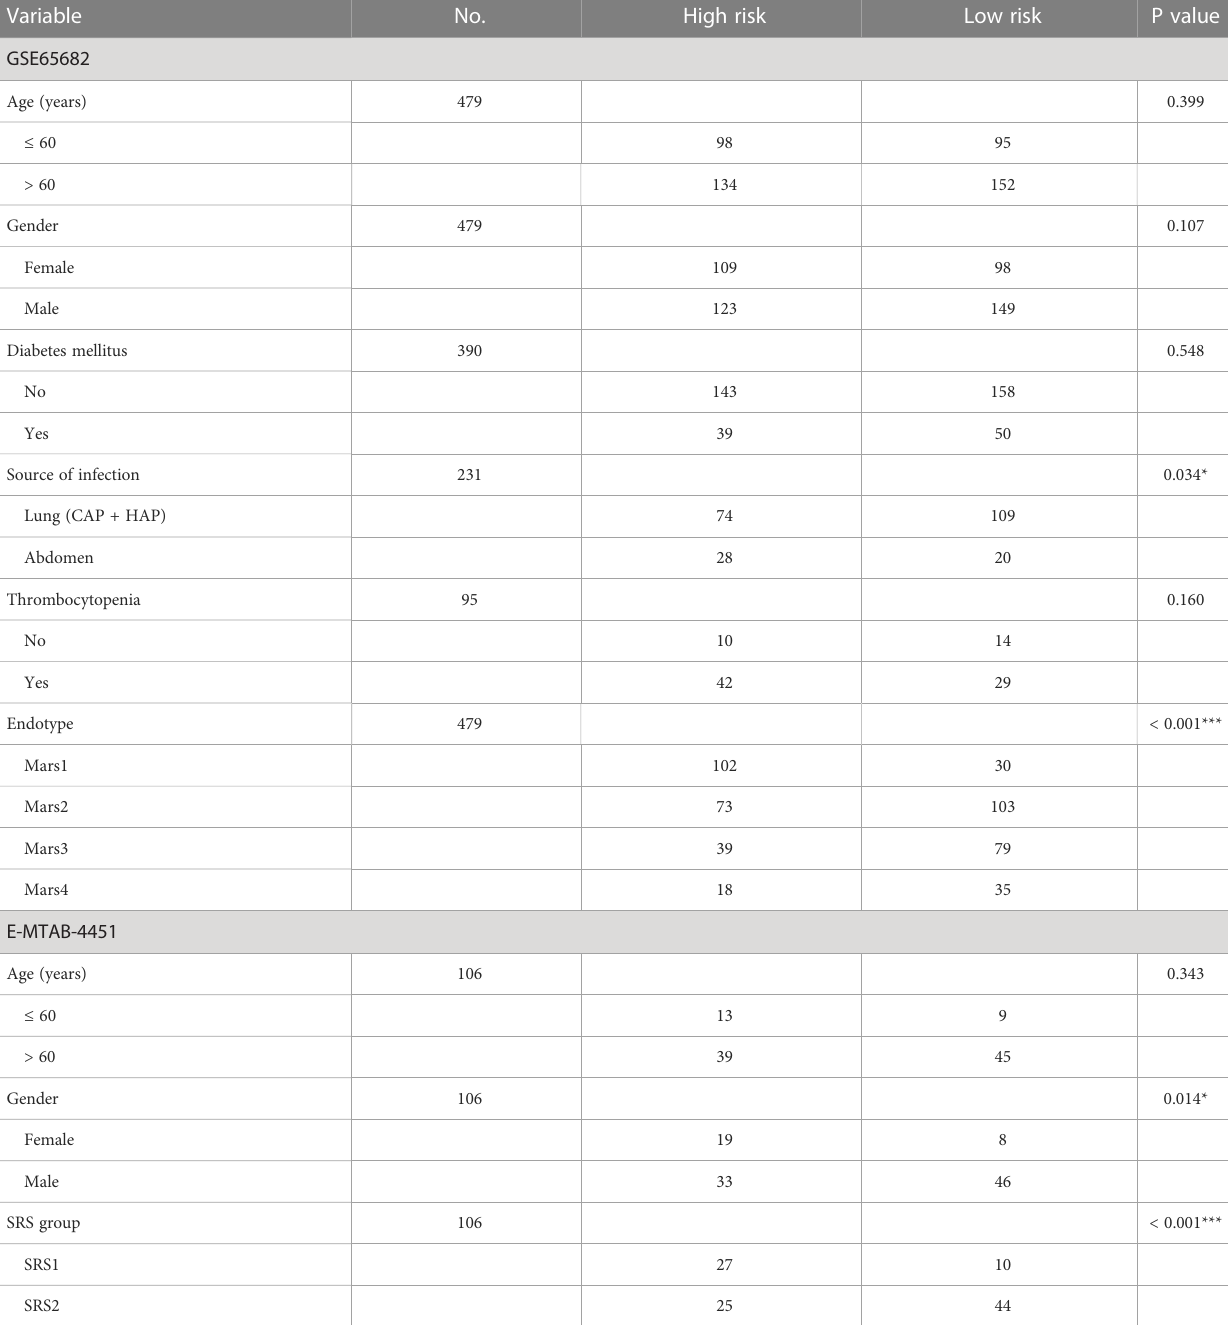
TABLE 3 Correlations between clinical characteristics and the identi fi ed IRG